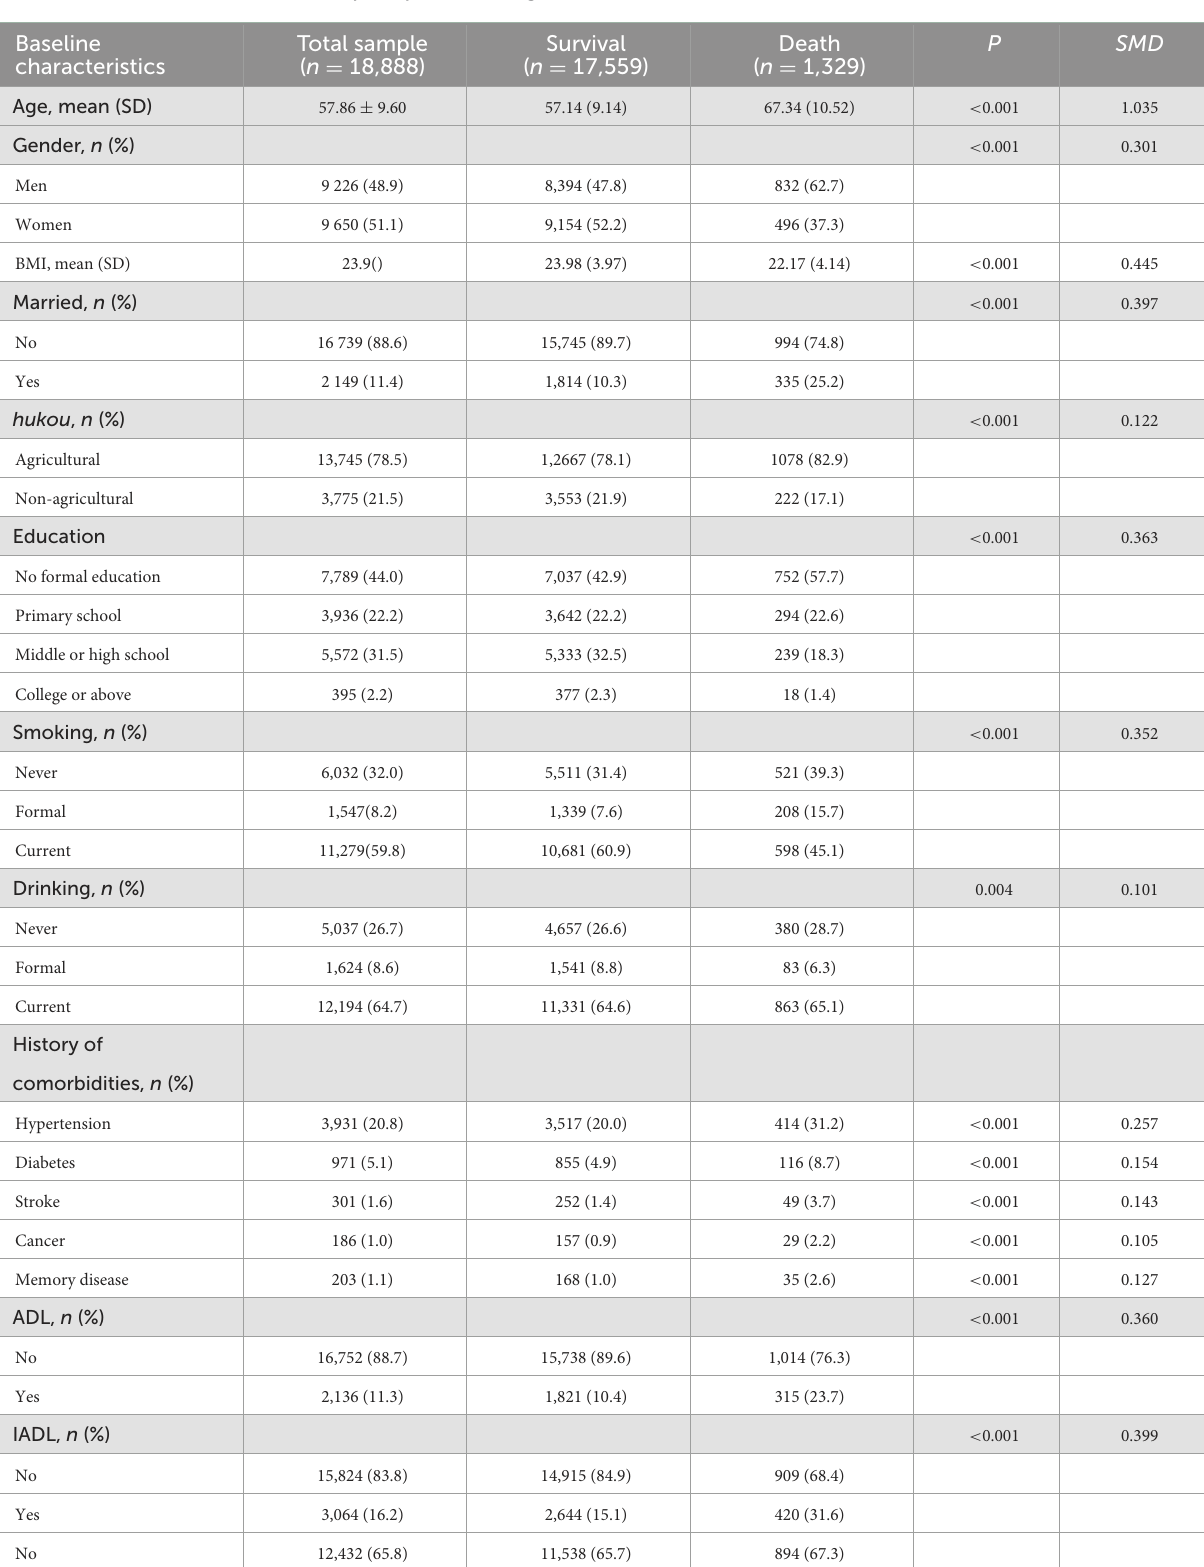
TABLE 1 Baseline characteristics of 18,888 participants according to death. Baseline